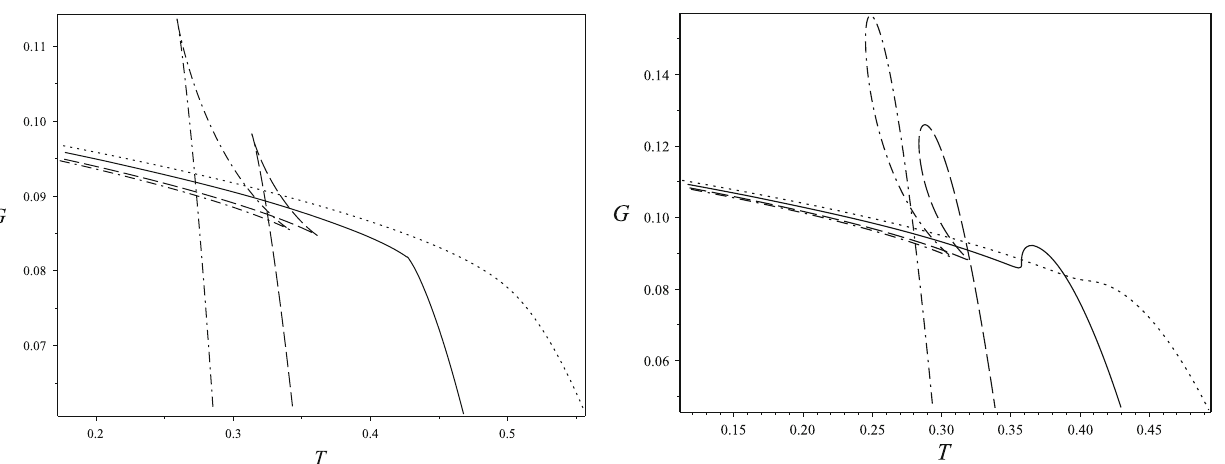
Fig. 6 Gibbs free energy as a function of temperature for different val- ues of pressure for n = 3, α = 0 . 1 (left graph), α = 0 . 5 (right graph), b = 1, q = 0 . 1. A solid curve corresponds to the value P = P c , a